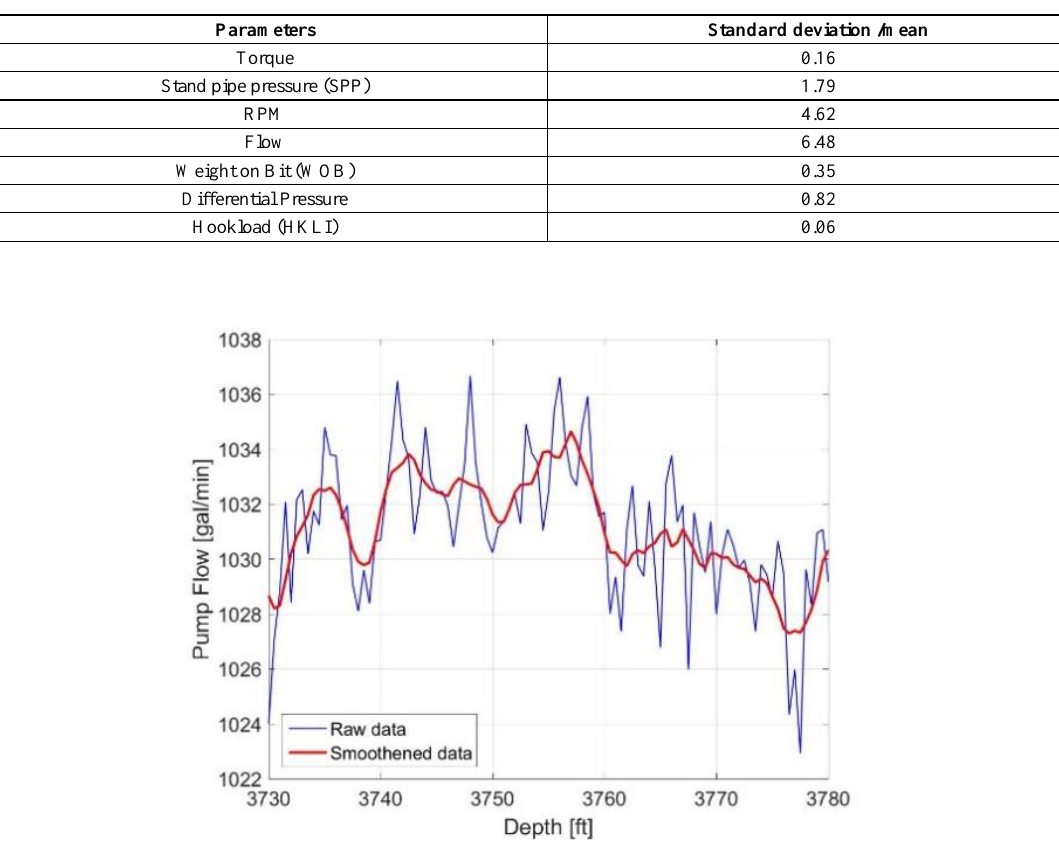
Figure 2. Smoothening of